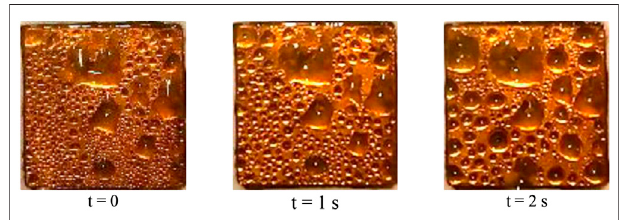
FIGURE 4 | Dropwise condensation process with pure steam (within a slip cycle).